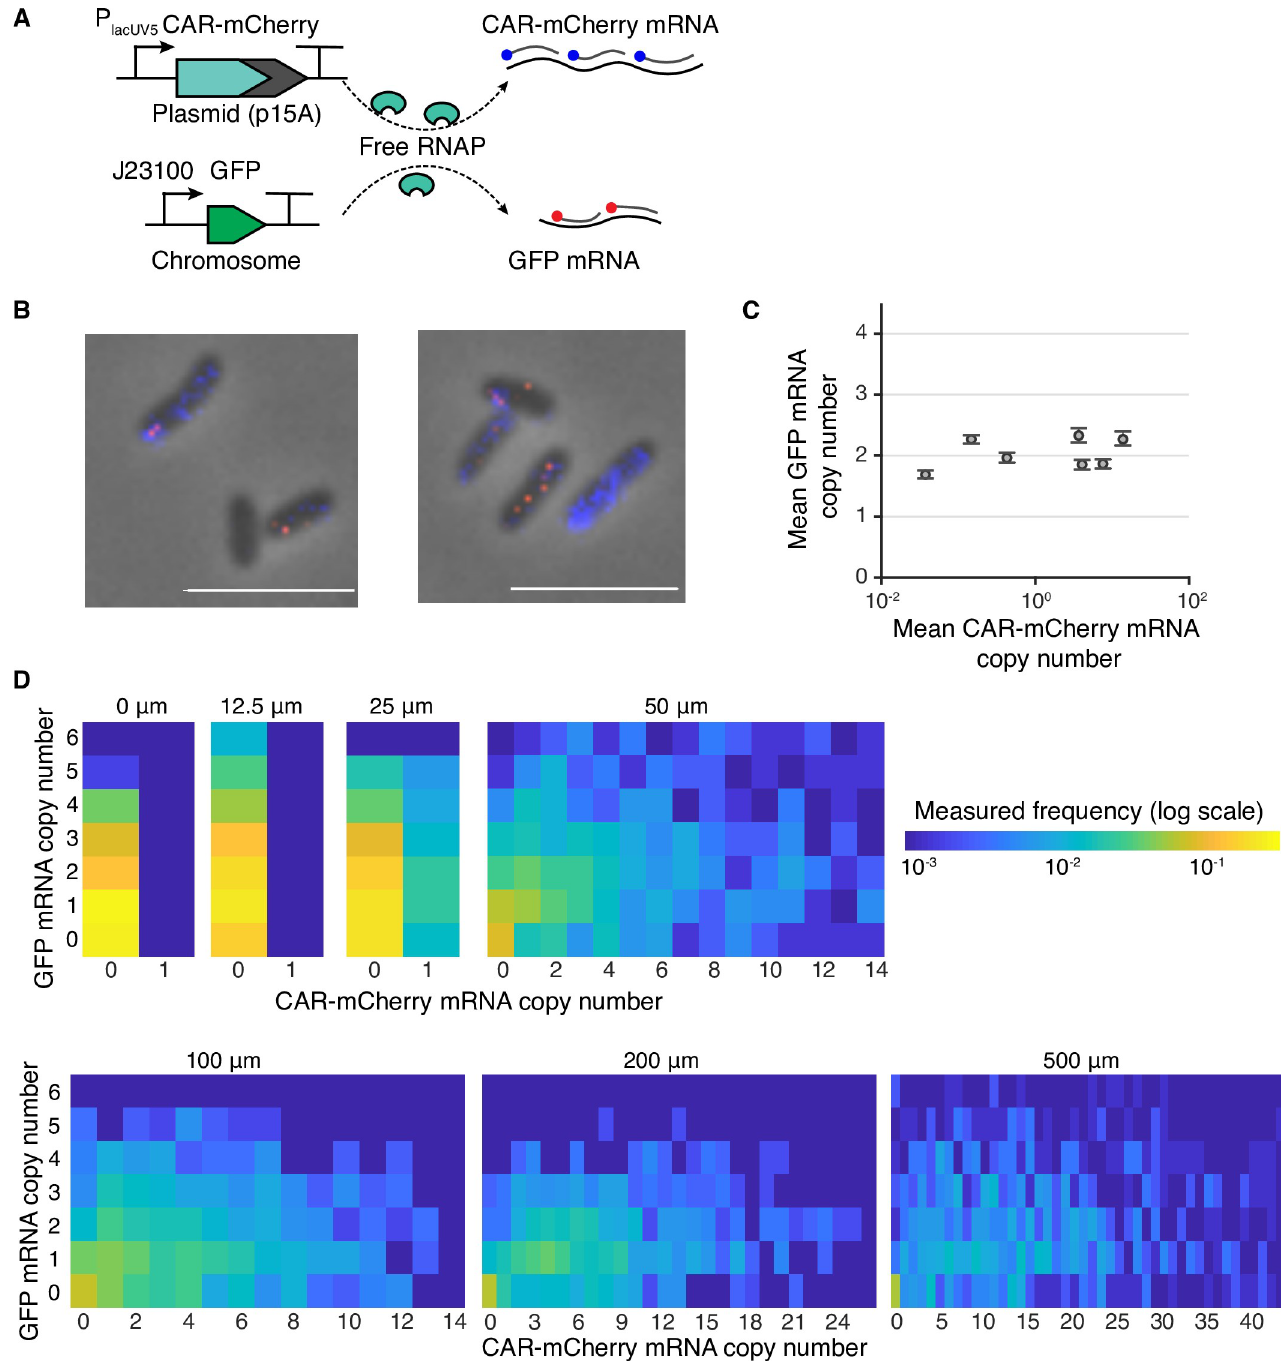
Fig 3. Multi-gene expression in single-cells during transcriptional competition. (A) Transcriptional competition between car-mCherry and gfp genes for limited shared RNAPs in single cells. CAR-mCherry mRNA and GFP mRNA were hybridized by Quasar 670- (blue) and Quasar 570-labeled (red) probes, respectively. The fluorescence of the mCherry protein was deactivated via the M71G mutation to prevent spectral overlap. (B) Representative FISH images of single cells induced at 500 μ M IPTG. (C) Population mean mRNA copy numbers of GFP and CAR-mCherry at various IPTG concentrations. mRNA copy numbers of CAR-mCherry and GFP were estimated from fluorescence intensity. Error bars represent the 95% confidence interval, determined by bootstrapping. (D) GFP and CAR-mCherry mRNA copy numbers of single cells at various IPTG induction levels.